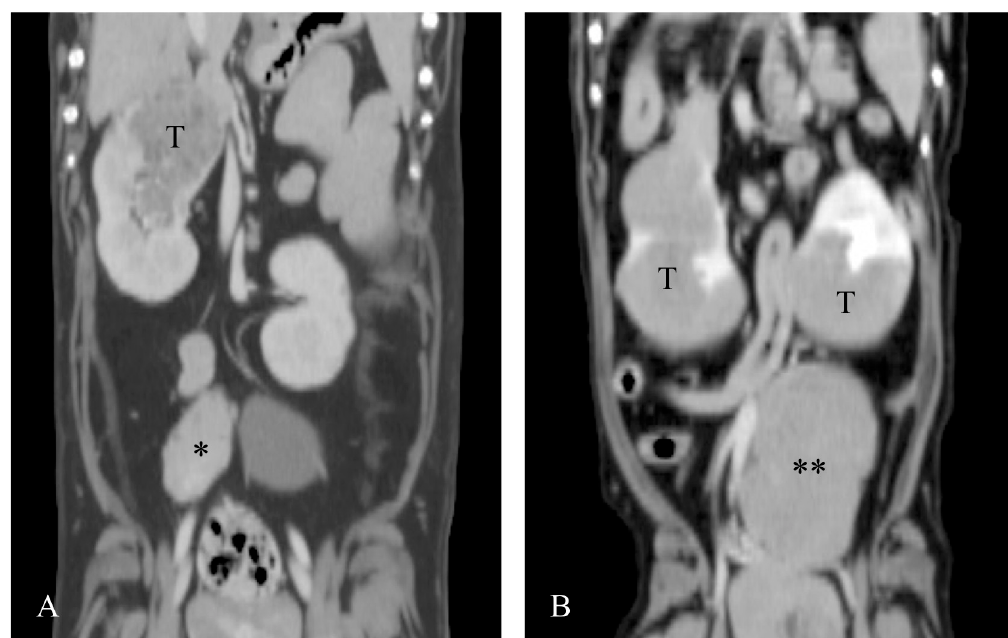
Fig 1. Coronal CT images of an RCC (A) and lymphoma (B). In the RCC case, an ipsilateral internal iliac lymph node was enlarged ( � ). In the lymphoma case, a unilateral internal iliac lymph node was severe enlarged ( �� ). Abbreviations: CT, computed tomography; RCC, renal cell carcinoma; T,